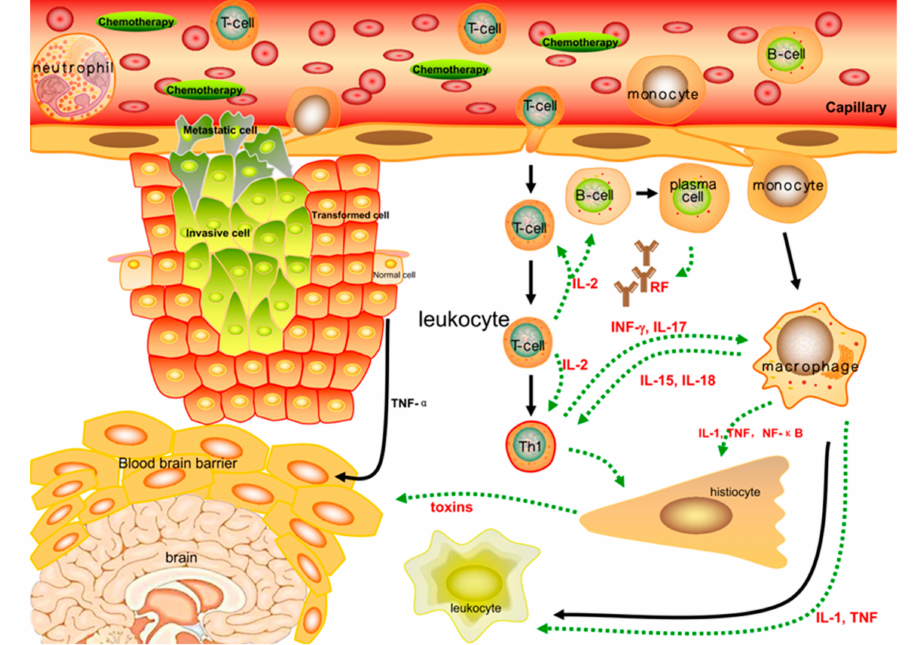
Figure 3. Inflammatory cytokines such as TNF- α , IL-1 β , IL-2, IL-6, and INF- γ , which are correlated